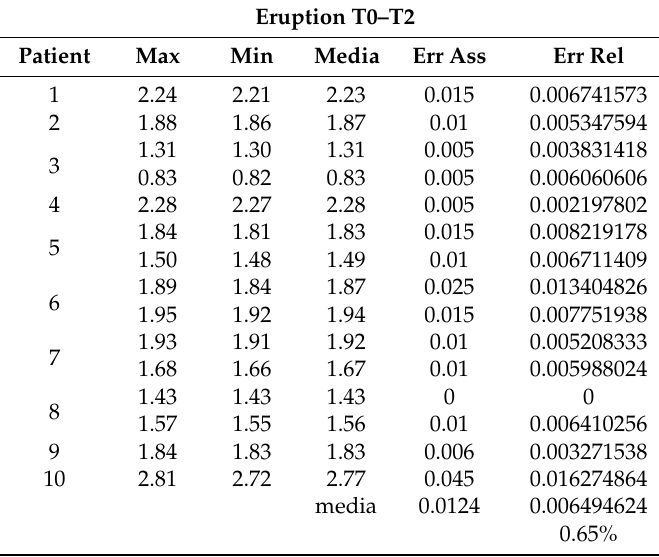
Table 10. Observational error to four months (T0–T2).